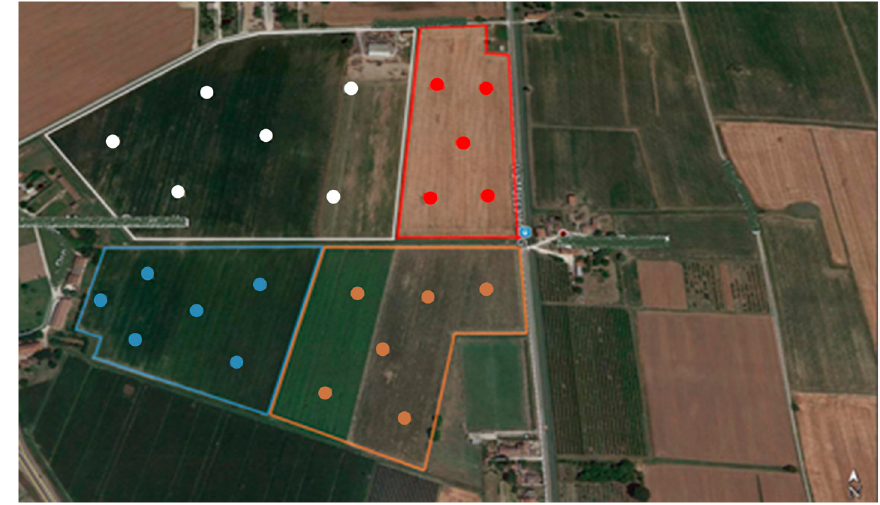
Figure 1. Sampling site area and sampling positioning (scale 1:200).